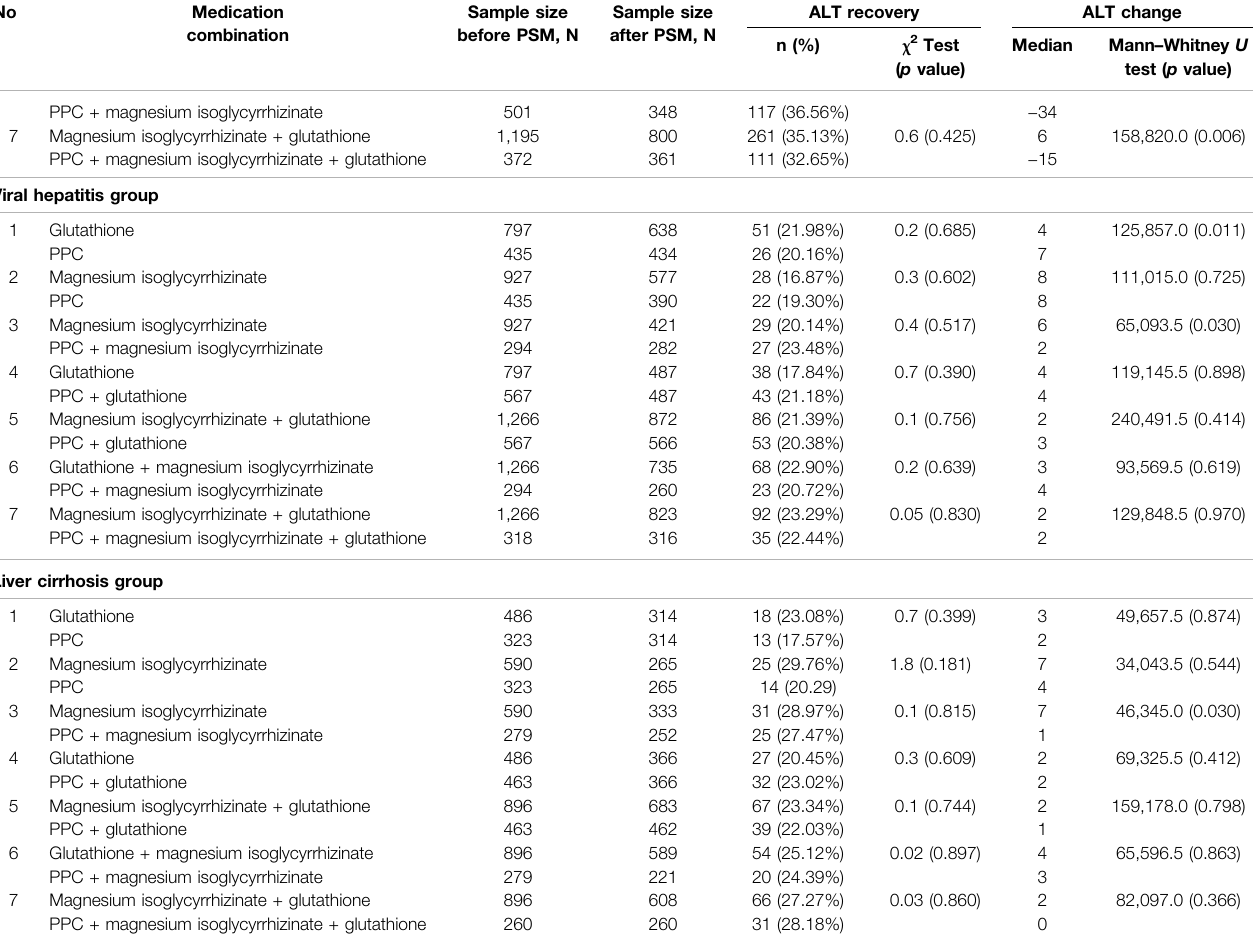
TABLE 4 | ( Continued ) ALT change value and test results in different medication